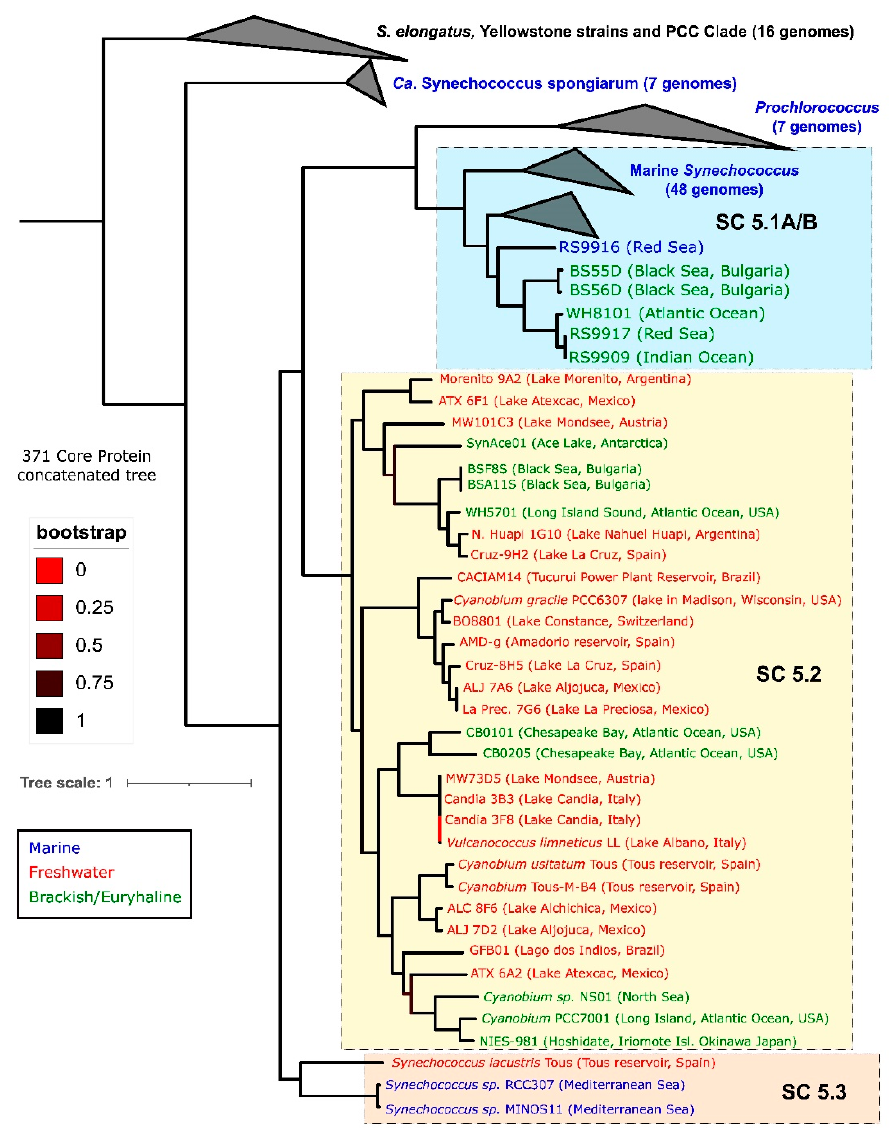
Figure 1. Protein-concatenated phylogenomic tree constructed with 371 core proteins with PhyloPhlAn3 tool. The tree includes all culture-derived picocyanobacteria from Synechococcus and Cyanobium genera inside sub-clusters 5.1, 5.2, and 5.3, a few Prochlorococcus representatives and Ca. Synechococcus spongiarum . The origin of each isolate is colour coded. The tree was rooted at the S. elongatus and PCC clade. Bootstrap values higher than 0.95 are marked as black squares on nodes. Modified from [26].